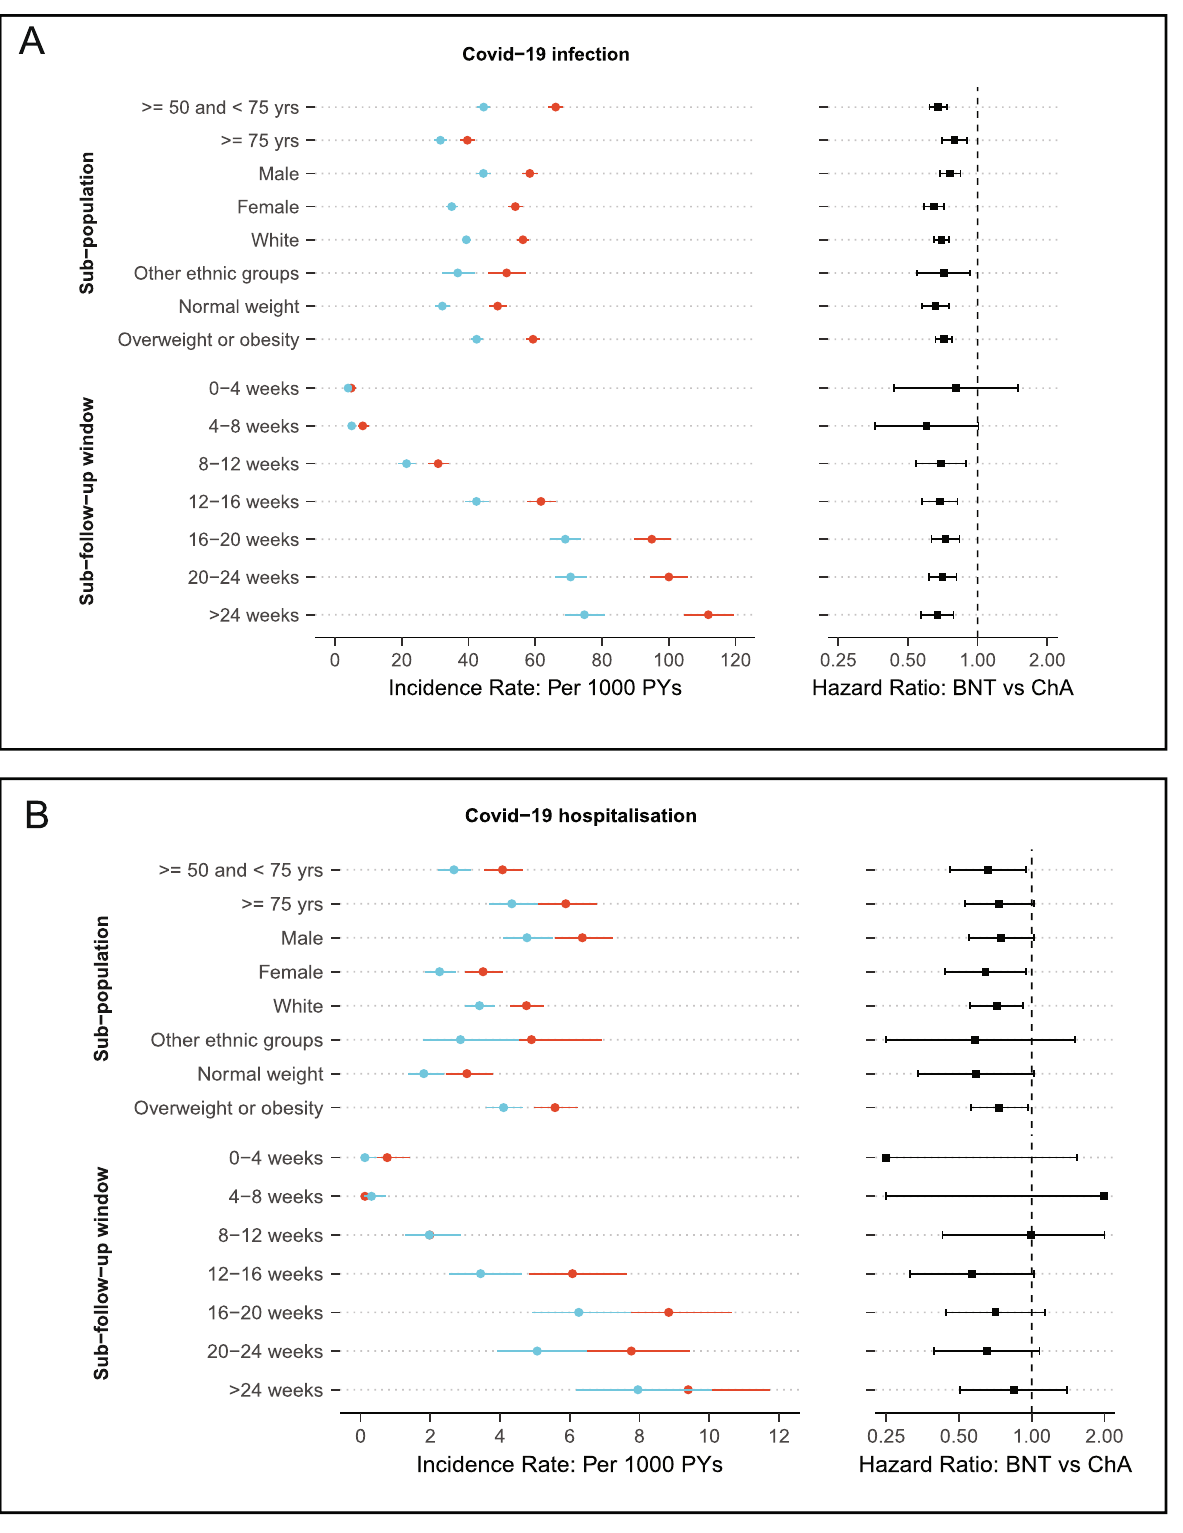
Fig. 4 Comparative effectiveness of two doses BNT162b2 vs ChAdOx1 vaccine on Covid-19 infection and hospitalisation across key subgroups and over time. The different X-axis range of incidence rate for the Covid-19 infection ( A ) and hospitalisation outcome ( B ). Hazard ratios for Covid-19 hospitalisation were truncated at 0.2 (lowest) and 2 (highest). Blue and red points indicated BNT162b2 and ChAdOx1 respectively. PYs: person-years. BNT: BNT162b2. ChA: